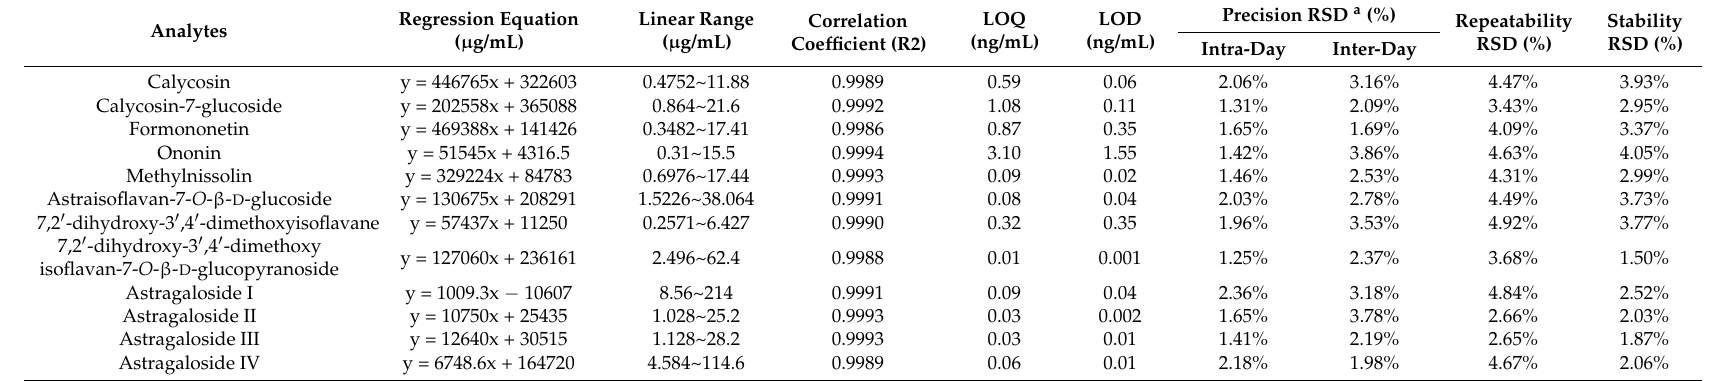
Table 2. Validation with respect to linearity, limit of quantification (LOQ), limit of detection (LOD), precision, repeatability and